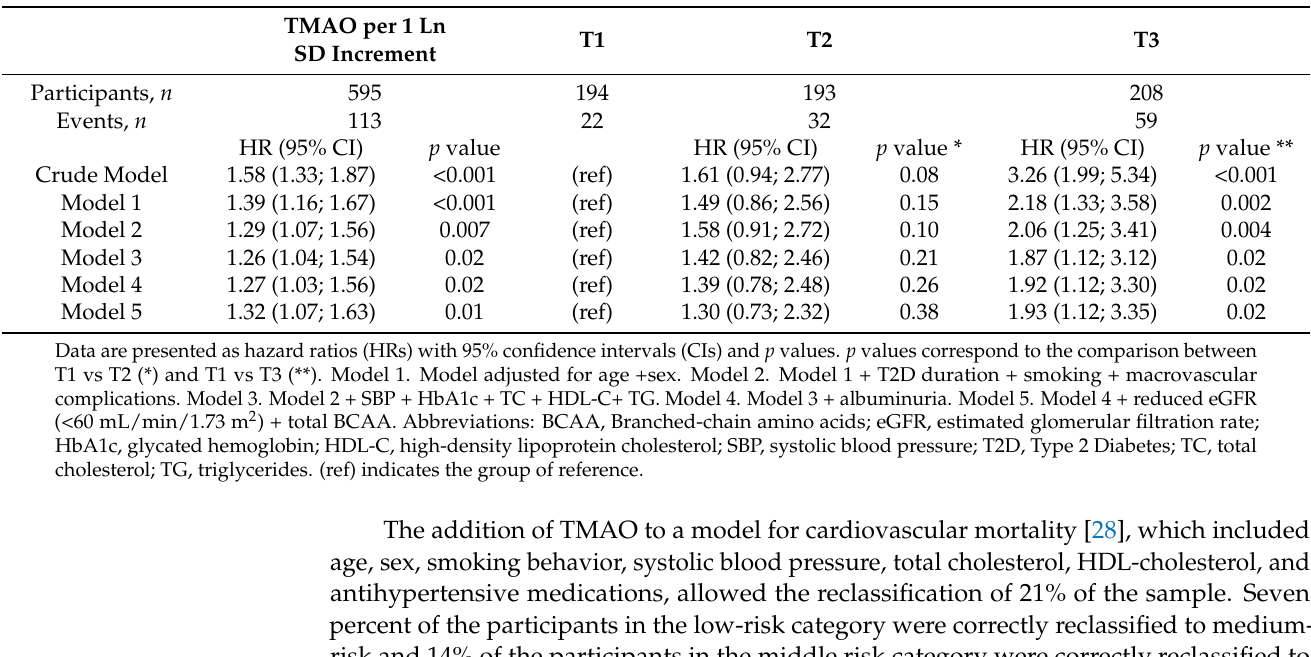
Figure 1. Kaplan-Meier plot for cardiovascular mortality comparing tertiles of TMAO (log-rank test, p < 0.001). Table 3. Association of TMAO with cardiovascular mortality, assessed with Cox Proportional Hazard